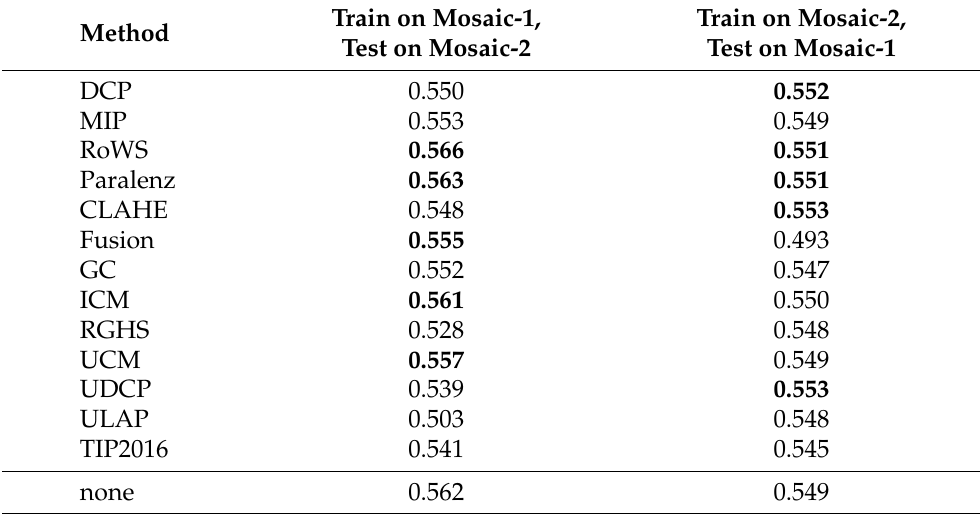
Table 4. The full shape segmentation performance by the IOU metric obtained after pre-processing underwater images by various colour restoration or image enhancement methods. Top 5 results for each column are denoted in bold face.